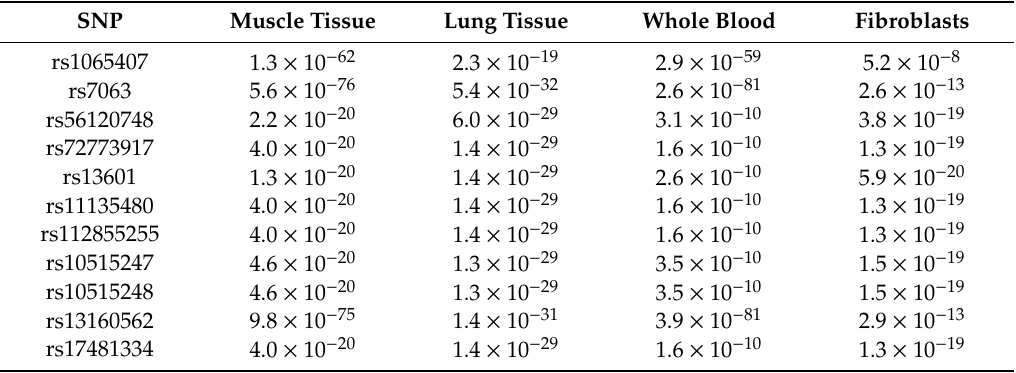
Table 4. Genotype-Tissue Expression (GETx) analysis of the functional SNPs located in HCMV miRNA target sites of the ERAP1 gene.